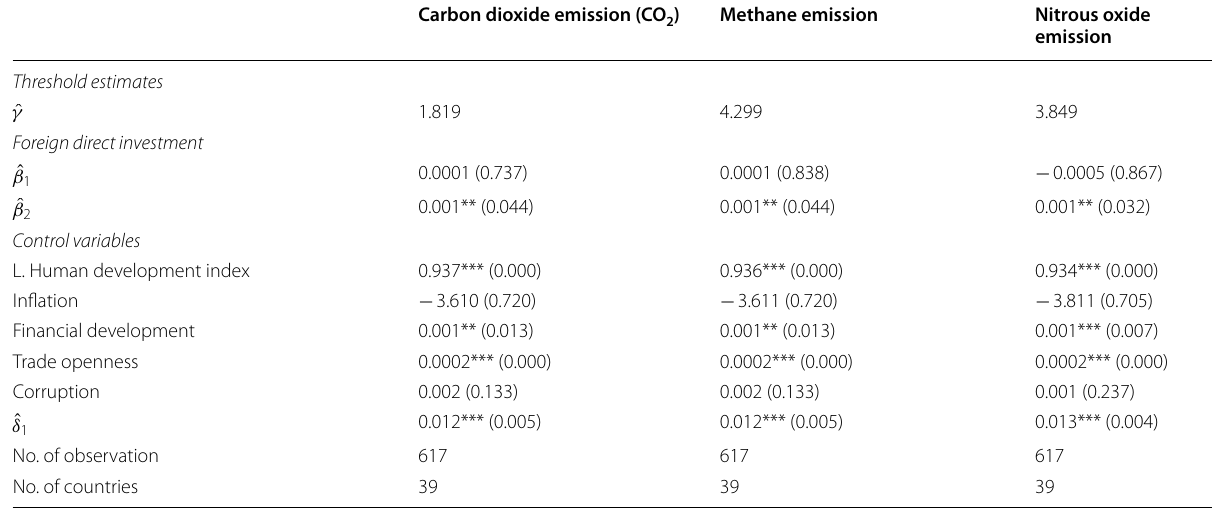
Table 4 Results of the dynamic threshold effect of the environmental degradation on foreign direct investment and poverty reduction (dependent variable: human development